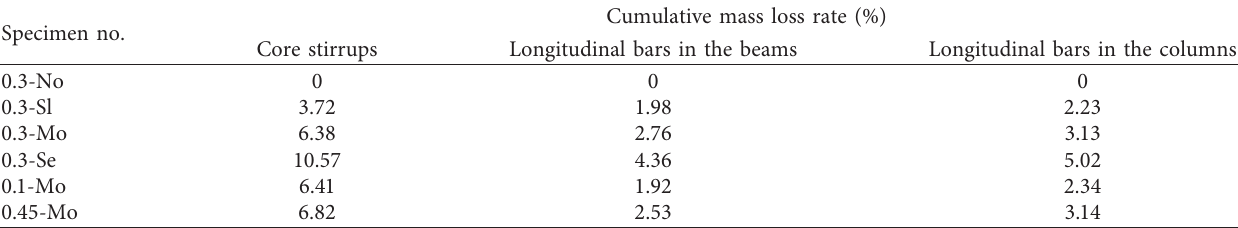
Table 3: Average cumulative mass loss rate of reinforcements.